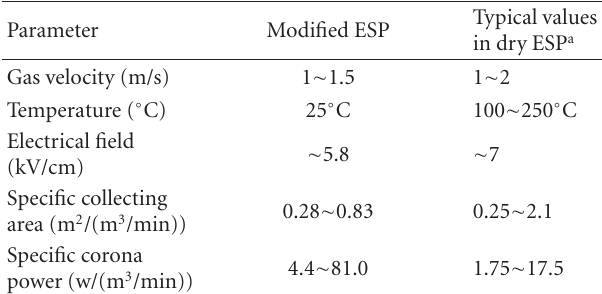
Table 1: Basic parameters of the modified wet ESP system investigated in this study.